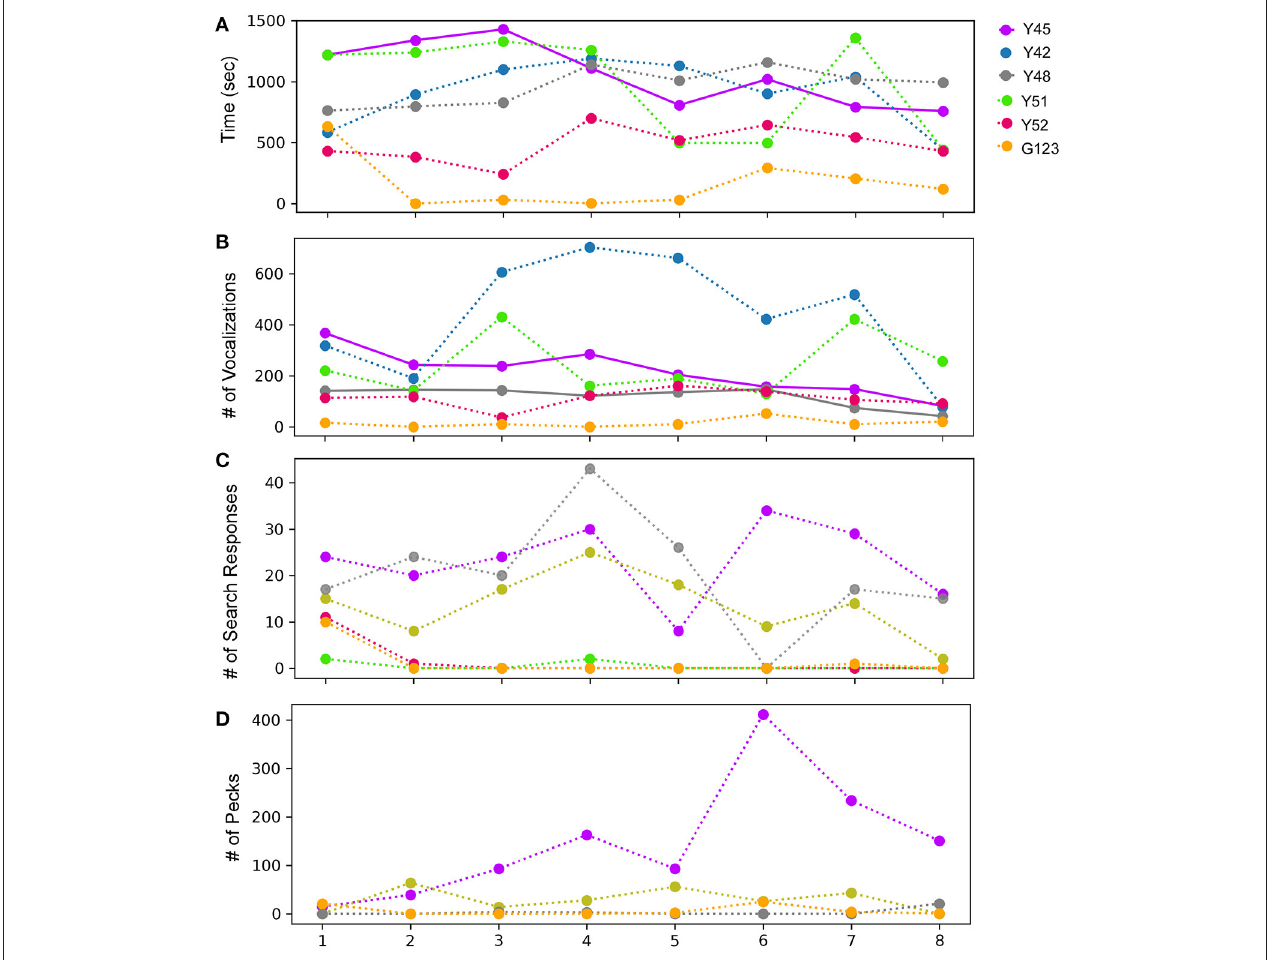
FIGURE 2 | Behavior following observations of mirror images for adult male zebra finches across eight successive sessions during the mirror exposure phase. (A) Time spent while facing the mirror, (B) number of vocalizations (calls or songs) directed toward the mirror image, (C) number of search responses (looking behind the mirror and turning clockwise or anticlockwise) performed while facing the mirror, and (D) aggressive behavior, measured by the number of pecks on the mirror or on its sides. Colors indicate different birds, bold lines indicate significantly increasing or decreasing linear trends ( P < 0.05; paired t -test) as trials progressed, which were highly variable across birds, whereas fainter dotted lines indicate no significant differences for each